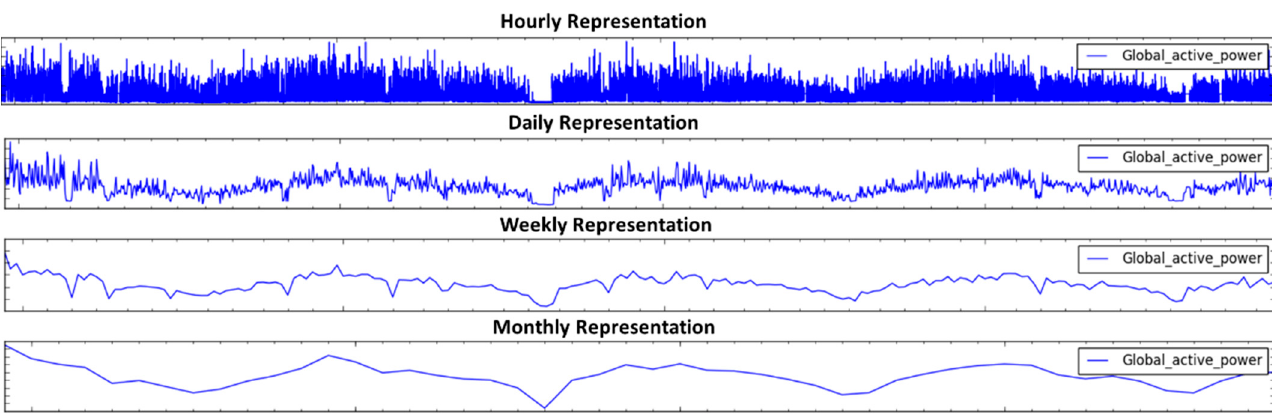
Figure 4. Visual presentation of total active power in the household dataset.